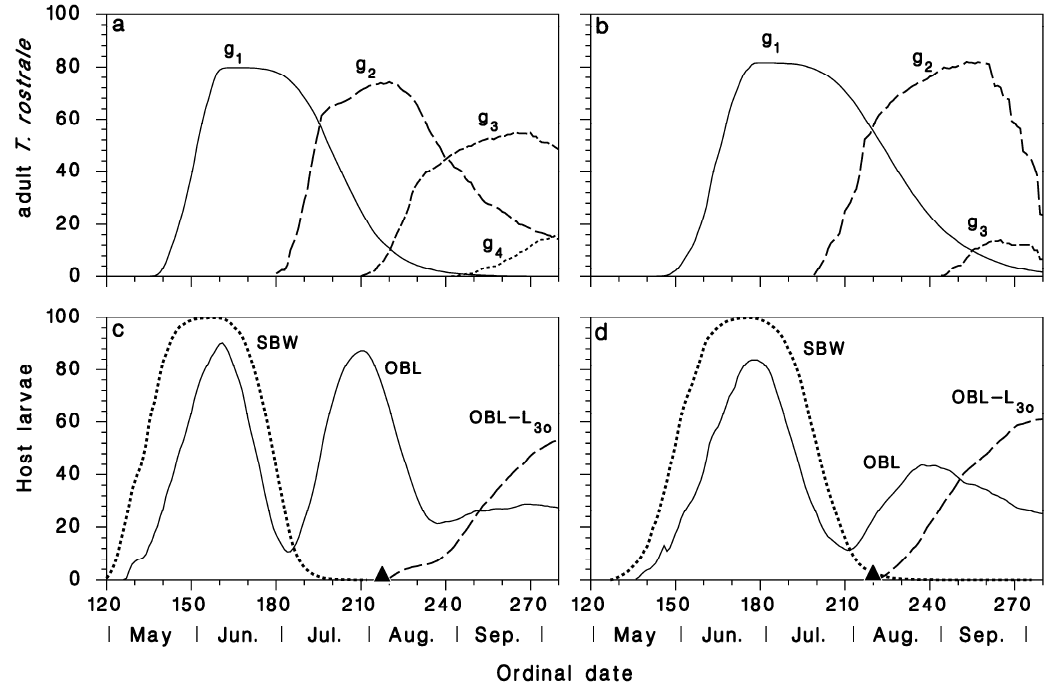
Figure 7. Tranosema rostrale model, diapause Scenario 1 (in tree), age of in-host diapause a D = 0.1, averaged over the period 1988–2017 in Armagh and Epaule. Abundance of successive generations of T. rostrale adults (initial g 1 to g 4 ) in ( a ) Armagh and ( b ) Epaule. Corresponding abundance of host larvae (SBW: ∙∙∙∙∙∙ ) and OBL (feeding larvae: ‒‒‒ , OBL-L 3o diapausing larvae: − − − ) in ( c ) Armagh and ( d ) Epaule. ▲ : Date when daylength < 14.5 h.